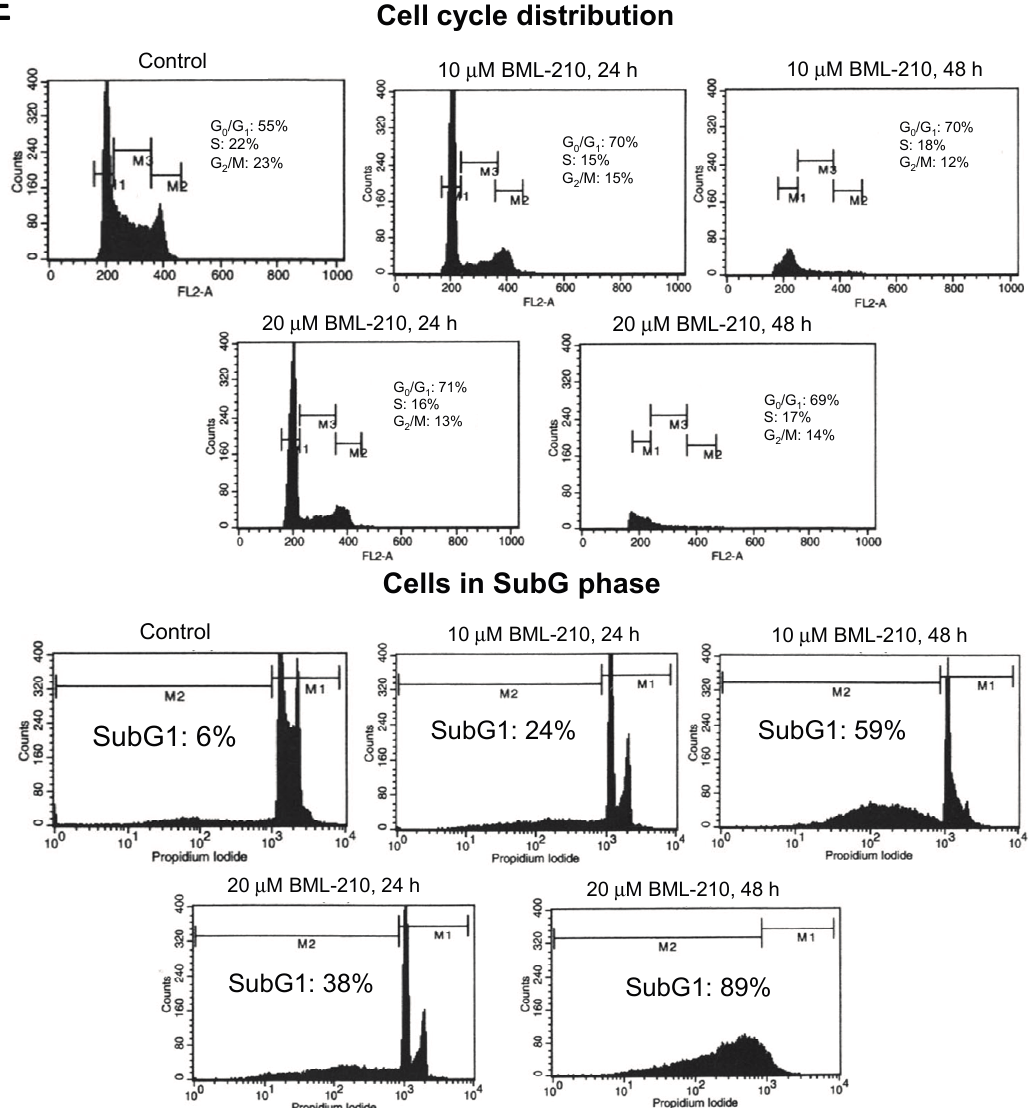
Figure 1. Effects of BML-210 on NB4 cell growth inhibition, survival and cell cycle distribution. Cells were treated with BML-210 at the indicated concentrations for three days. ( A ) The percentage of cell growth inhibition; ( B ) Viable cell number was determined daily by counting in a hemocytometer after staining with 0.2% trypan blue; ( C ) Flow cytometric analysis of cell cycle distribution between G0/G1, S and G2/M phases (%) after treatments. Representative FACS-generated histograms of a hypodiploid peak (subG1) in control cells and after treatment with BML-210 for 24 and 48 h (presented in ( E )); ( D ) Apoptosis was determined as a hypodiploid peak (subG1) from flow cytometric analysis of PI stained cells. Apoptosis is presented as a percentage of the total events collected. Representative FACS-generated histograms of a hypodiploid peak (subG1) in control cells and after treatment with BML-210 for 24, 48 h (presented in ( E )). Results are mean ± SEM ( n = 3). * p < 0.05, ** p < 0.001 and *** p < 0.0001. Thus, BML-210 can cause growth arrest in the transition through the cell cycle and induces cytotoxicity through the pathway of